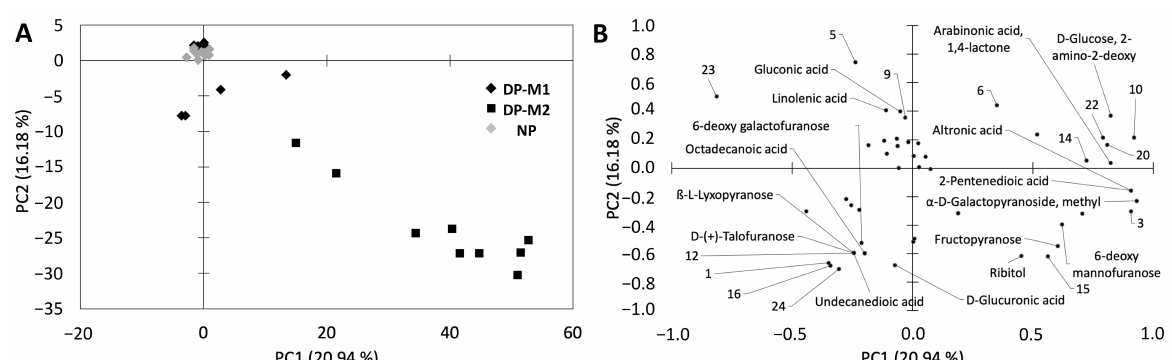
Figure 2. PCA score ( A ) and loading ( B ) plots of the metabolite profile from Musa AAA cv. Williams samples at the proliferation phase (end of 3rd subculture) coming from meristem M1 (N1–N10: normal plants, D1–D10: dwarf plants), for which the PCA was performed. Additionally, the plants M2 DP (11–19) are also visualized as an assessment set. Metabolites numbers in the loading plot correspond to Table